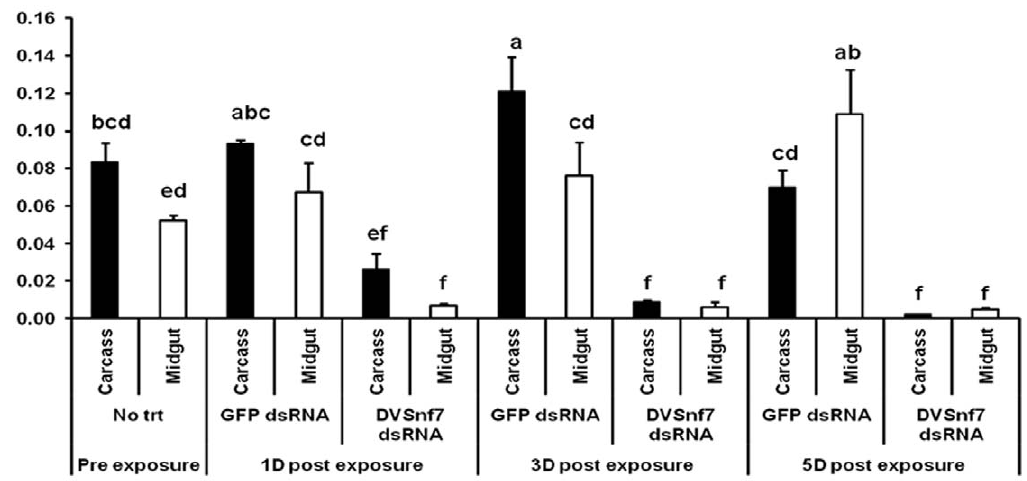
Figure 4. RNAi effect spreads to other tissues beyond the midgut in Western Corn Rootworm (WCR, Diabroticavirgiferavirgifera ). DvSnf7 mRNA levels were decreased in isolated midgut and carcass tissues of second instar larvae fed for 24 hours with 1000 ng/mL diet of DvSnf7 240 bp dsRNA, as assessed by Real-time RT-PCR. Further mRNA suppression is observed in the carcass and midgut at days 3 and 5 post-feeding. Means followed by same letter are not significantly different (p=0.05;